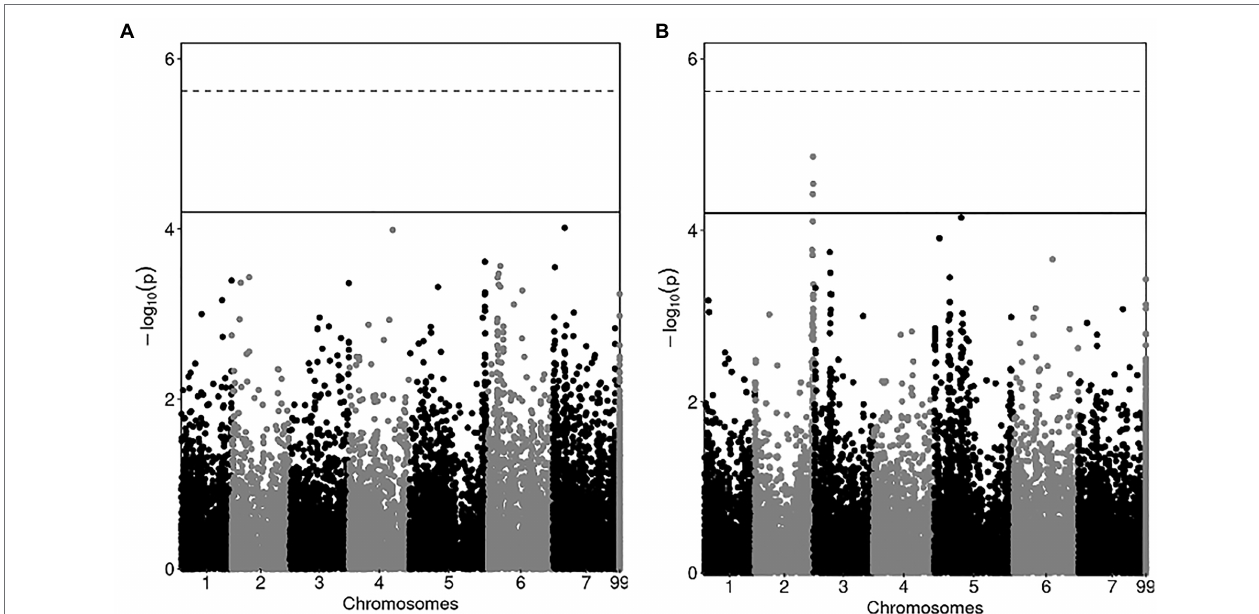
FIGURE 1 | Manhattan plots showing the association score of SNP markers with grain yield (A) and grain protein content (B) along pea chromosomes in a GWAS based on 306 lines belonging to three connected RIL populations. The dashed line represents the Bonferroni correction threshold, while the solid line represents False Discovery Rate threshold in (A) , and the threshold employed to select significantly associated markers in (B)